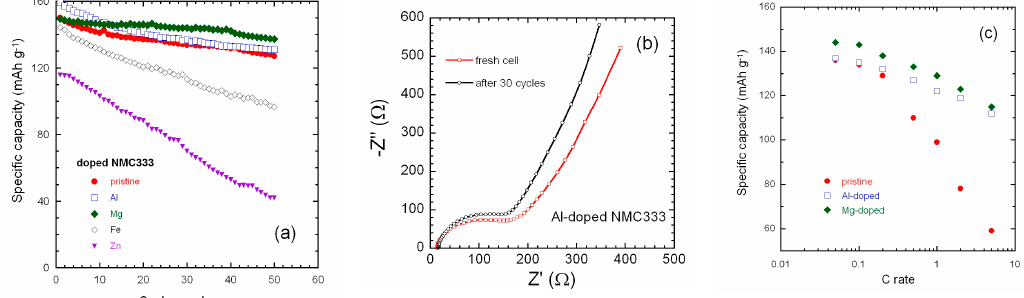
Figure 10. ( a ) Cyclability of parent and doped LiNi 1/3 Mn 1/3 Co 1/3 O 2 cathode materials recorded 0.1C rate in the potential range 2.5–4.5 V versus Li + / Li 0 ; ( b ) electrochemical impedance spectroscopy at a 0.1C rate in the potential range 2.5–4.5 V versus Li + /Li 0 ; ( b ) electrochemical impedance (EIS) results for a LiNi 1 / 3 Mn 1 / 3 Co 1 / 3 O 2 // Li cell before and after cycling at 0.1C rate; ( c ) rate capability of spectroscopy (EIS) results for a LiNi 1/3 Mn 1/3 Co 1/3 O 2 //Li cell before and after cycling at 0.1C undoped and Al- and Mg-doped NMC333 electrodes after 30 rate; ( c ) rate capability of undoped and Al- and Mg-doped NMC333 electrodes after 30 cycles.